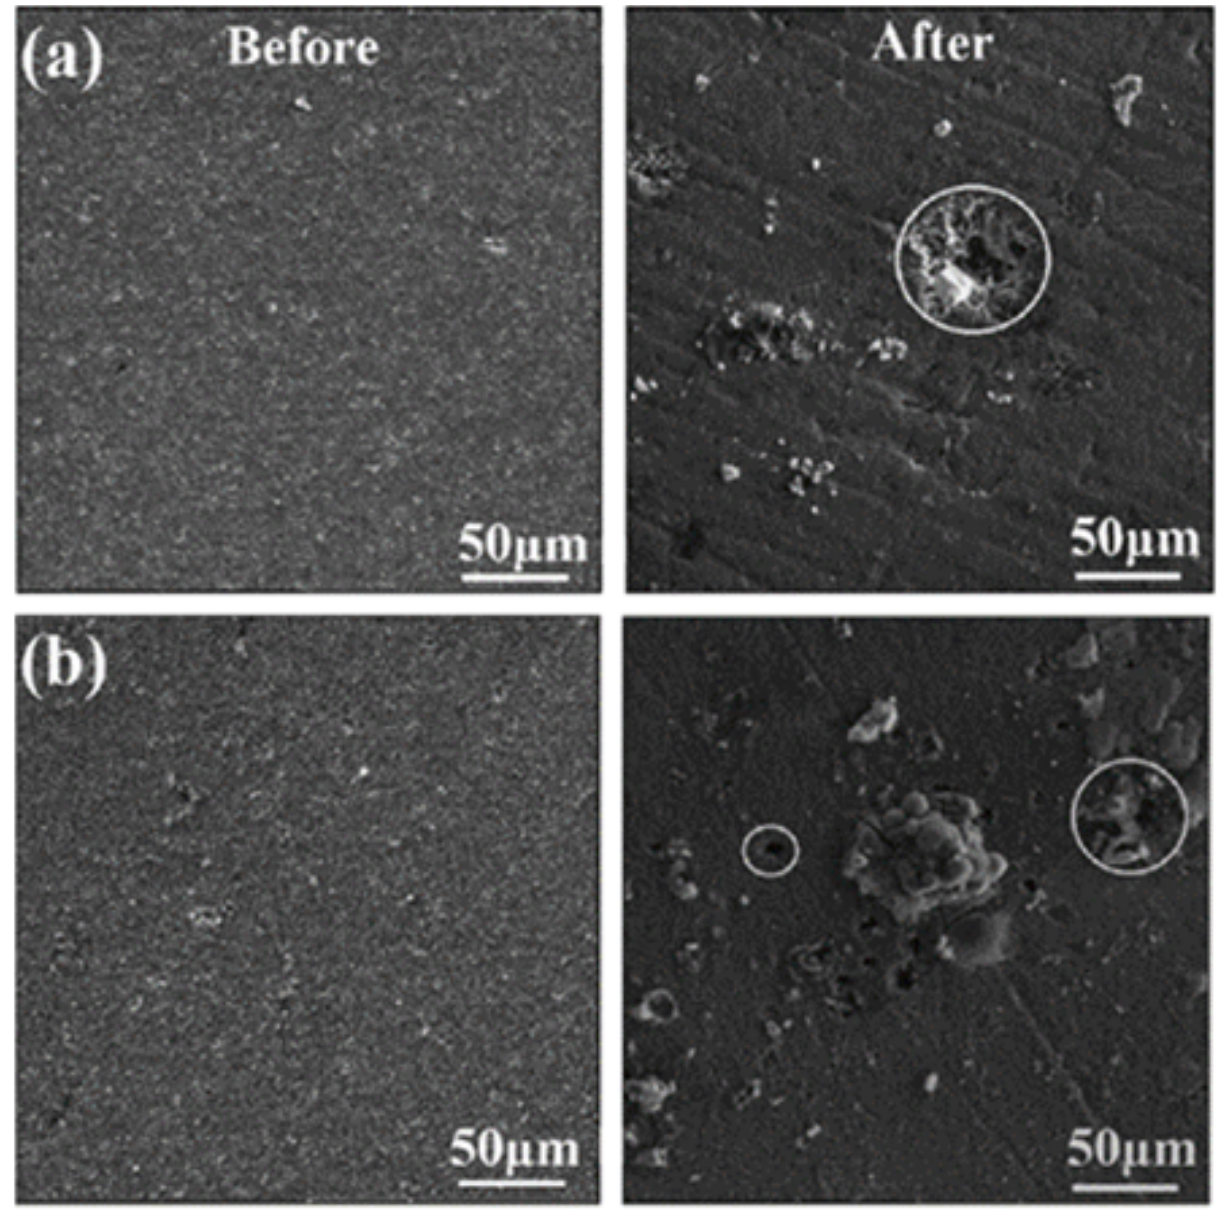
Figure 24: Before and after SEM images of (a, b) pure Al and (c, d) 0.5 wt% GNP-Al composite. Reproduced from Reference